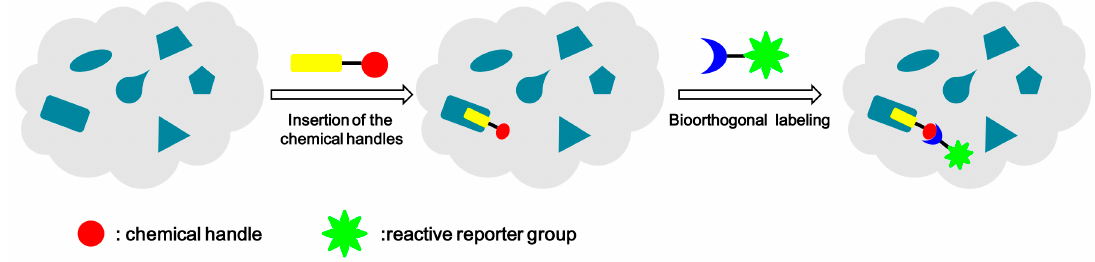
Figure 1. Bioorthogonal strategy for biomolecule labeling.